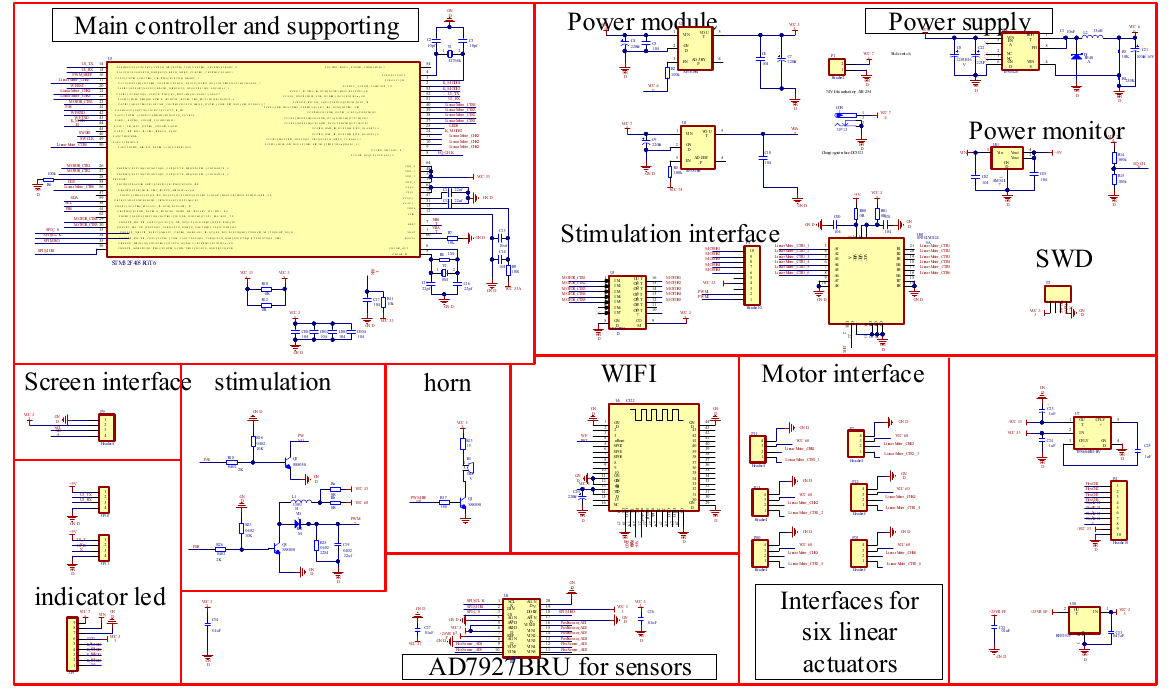
Figure 5. Schematic diagram of the circuit of the rehabilitation robot. Figures 4 and 5 show the hardware design of the rehabilitation robot. In the schematic part, the placement direction or labeling of some devices is not